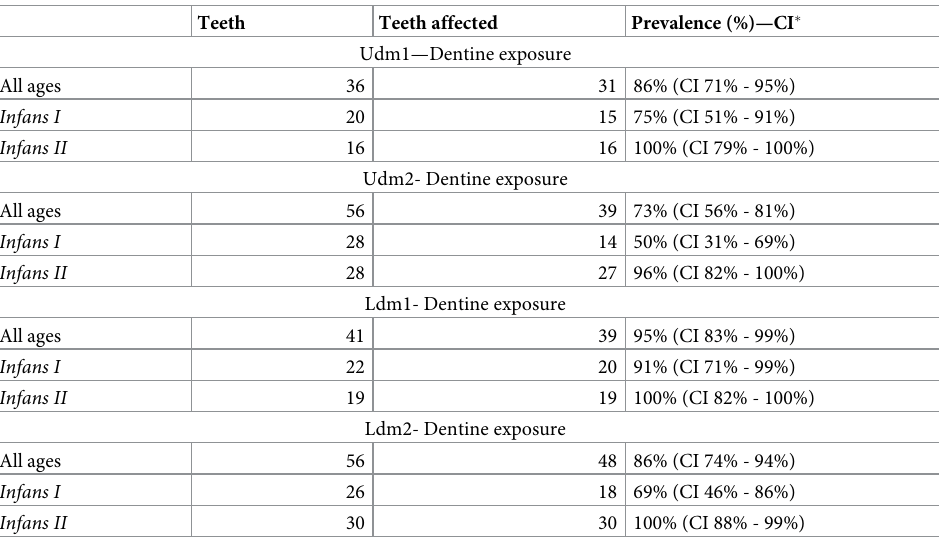
Table 2. Prevalence of dentine exposure for each deciduous